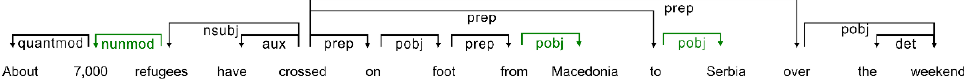
Figure 12. Dependency parsing results for a selected tweet. Highlighted in green are dependencies that indicate cardinality, origin, and destination.